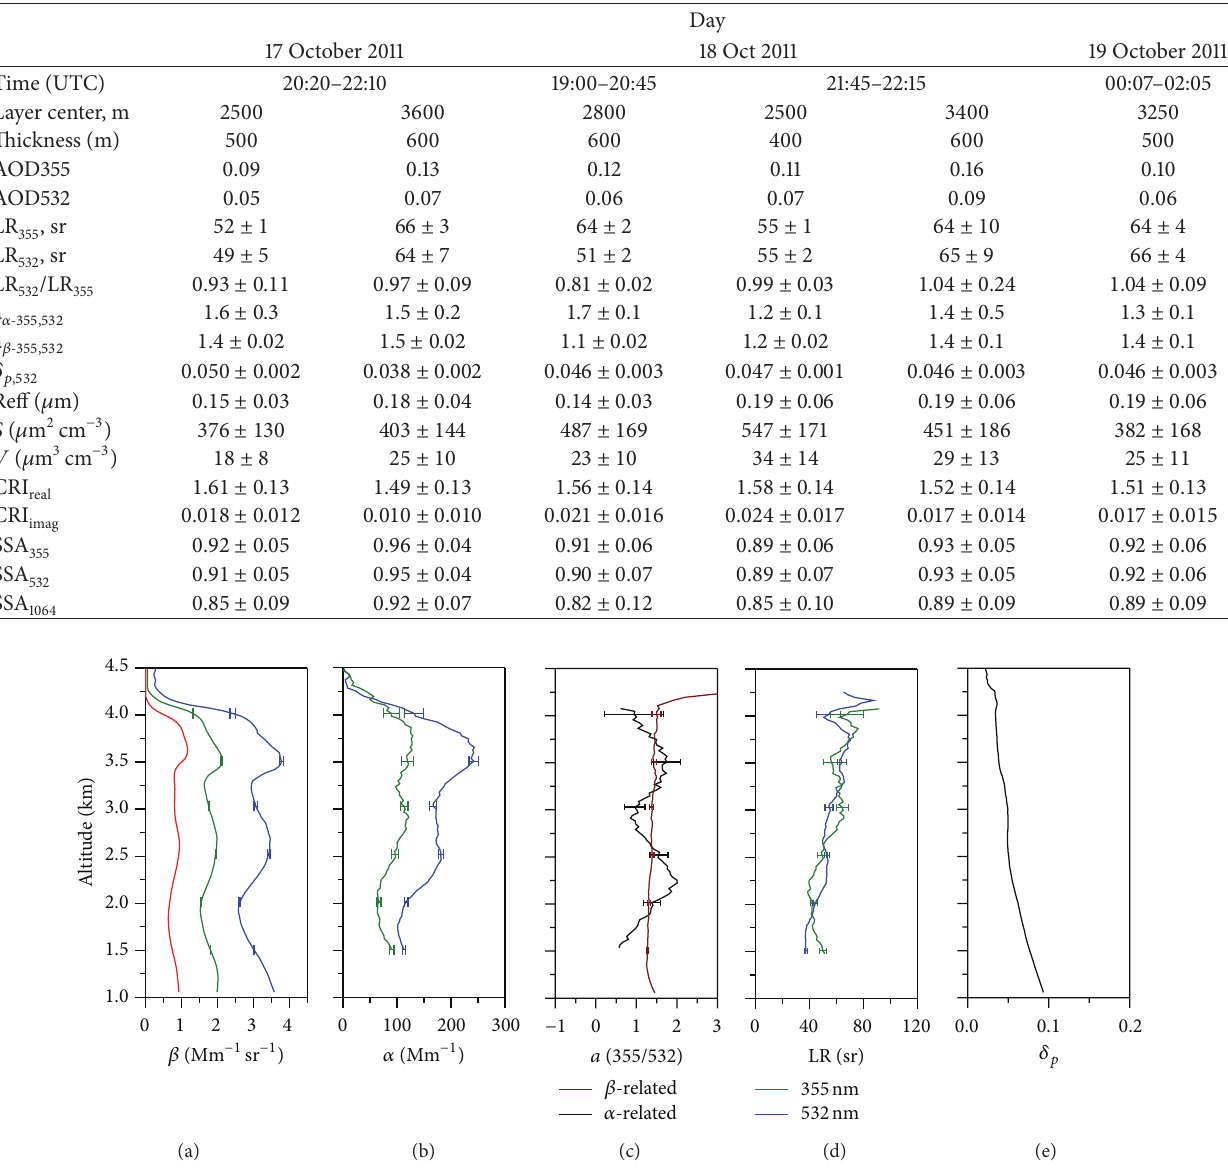
Table 1: Mean values of the optical and microphysical properties of the aerosol layers observed between 17 and 19 October 2011.